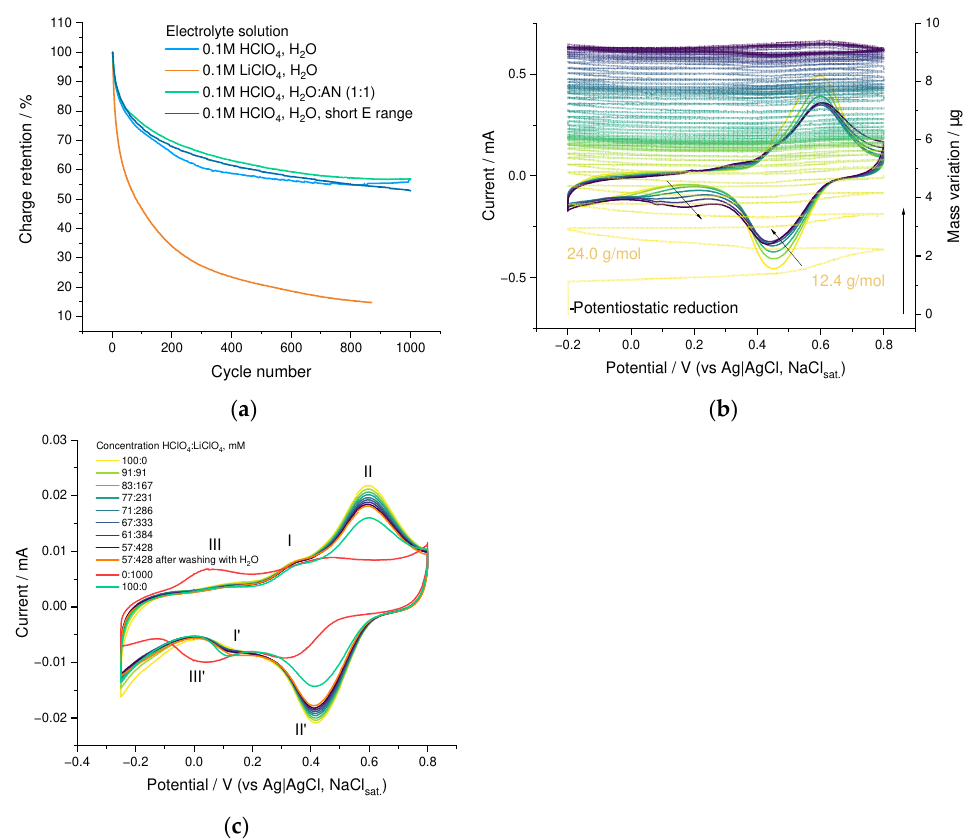
Figure 12. ( a ) Cycling stability of PEDOT:SPVC films in different cycling conditions, ( b ) 50 cycles of EQCM cycling of the PEDOT:SPVC film in 0.1 M HClO 4 , 20 mV·s −1 and ( c ) LiClO 4 titration of the PEDOT:SPVC film.